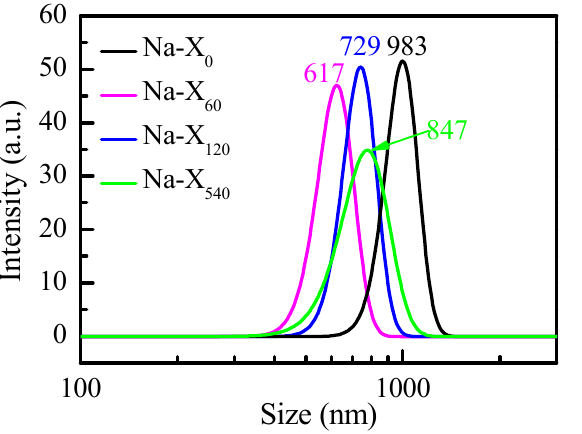
Figure 3. DLS curves for colloidal aqueous solutions of initial Na-X 0 zeolites and zeolites after milling for 60, 120, and 540 s.